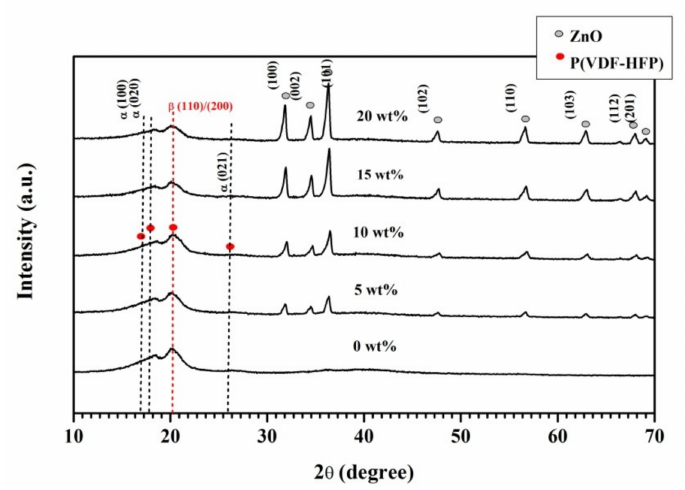
Figure 6. XRD analysis of P(VDF-HFP) nanofibers pure and P(VDF-HFP)/ZnO composite nanofibers (5, 10, 15, and 20 wt%).